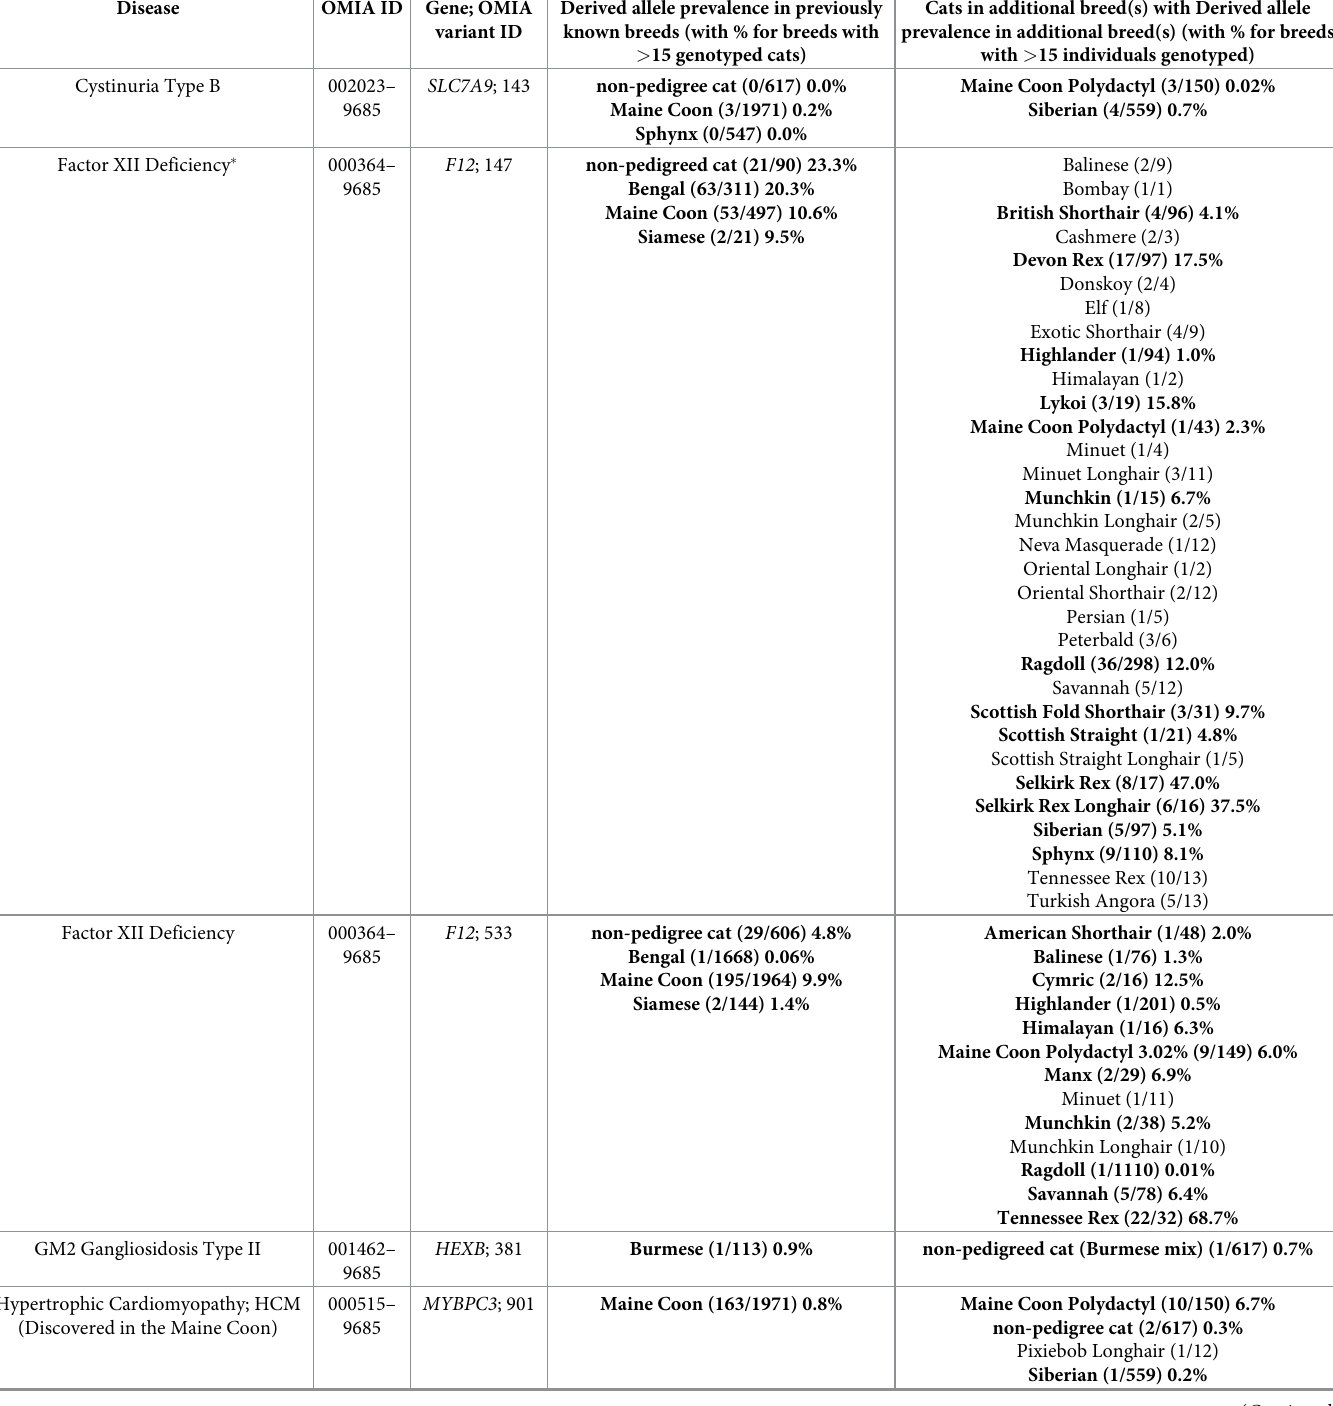
Table 2. Summary of disease-associated variant findings in additional breeds and breed